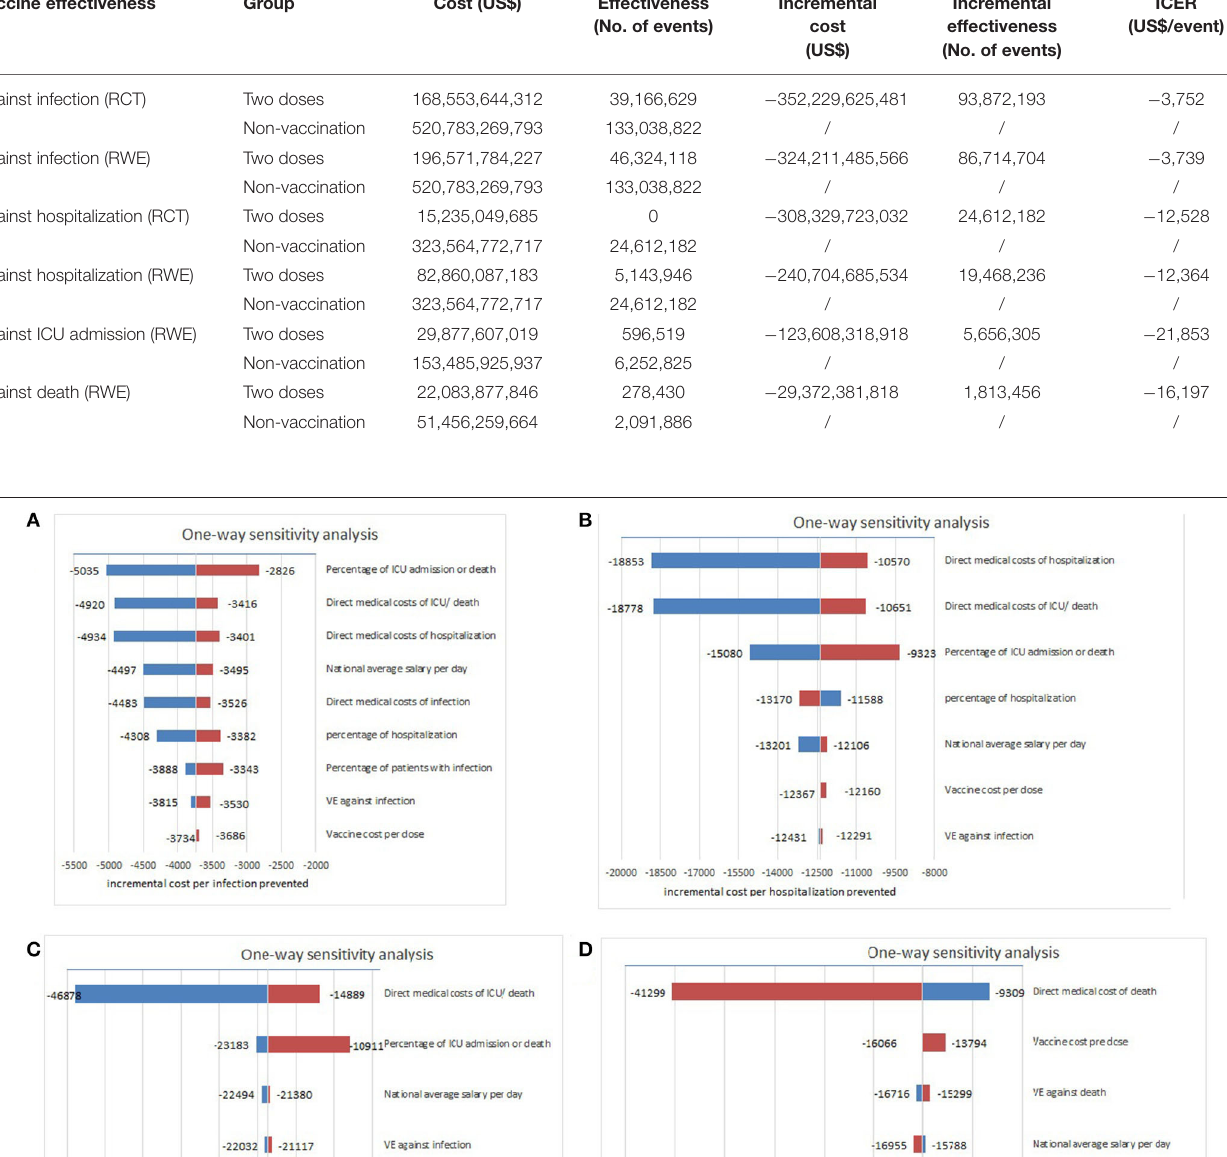
TABLE 2 | Cost-effectiveness of inactivated vaccine against COVID-19 infection, hospitalization, ICU admission, and death. Vaccine effectiveness Group